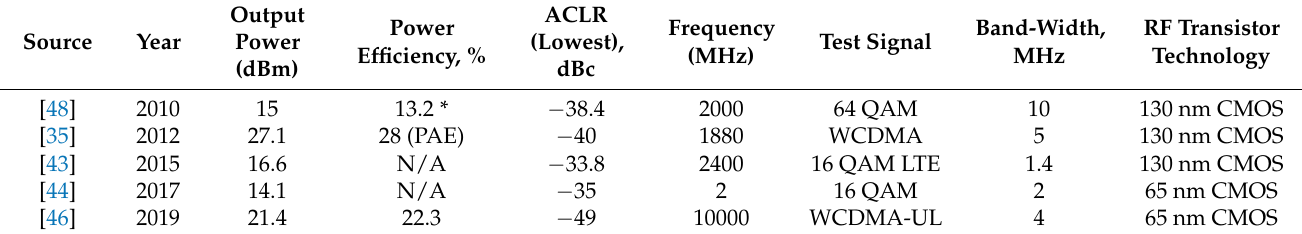
Table 2. Feedback method